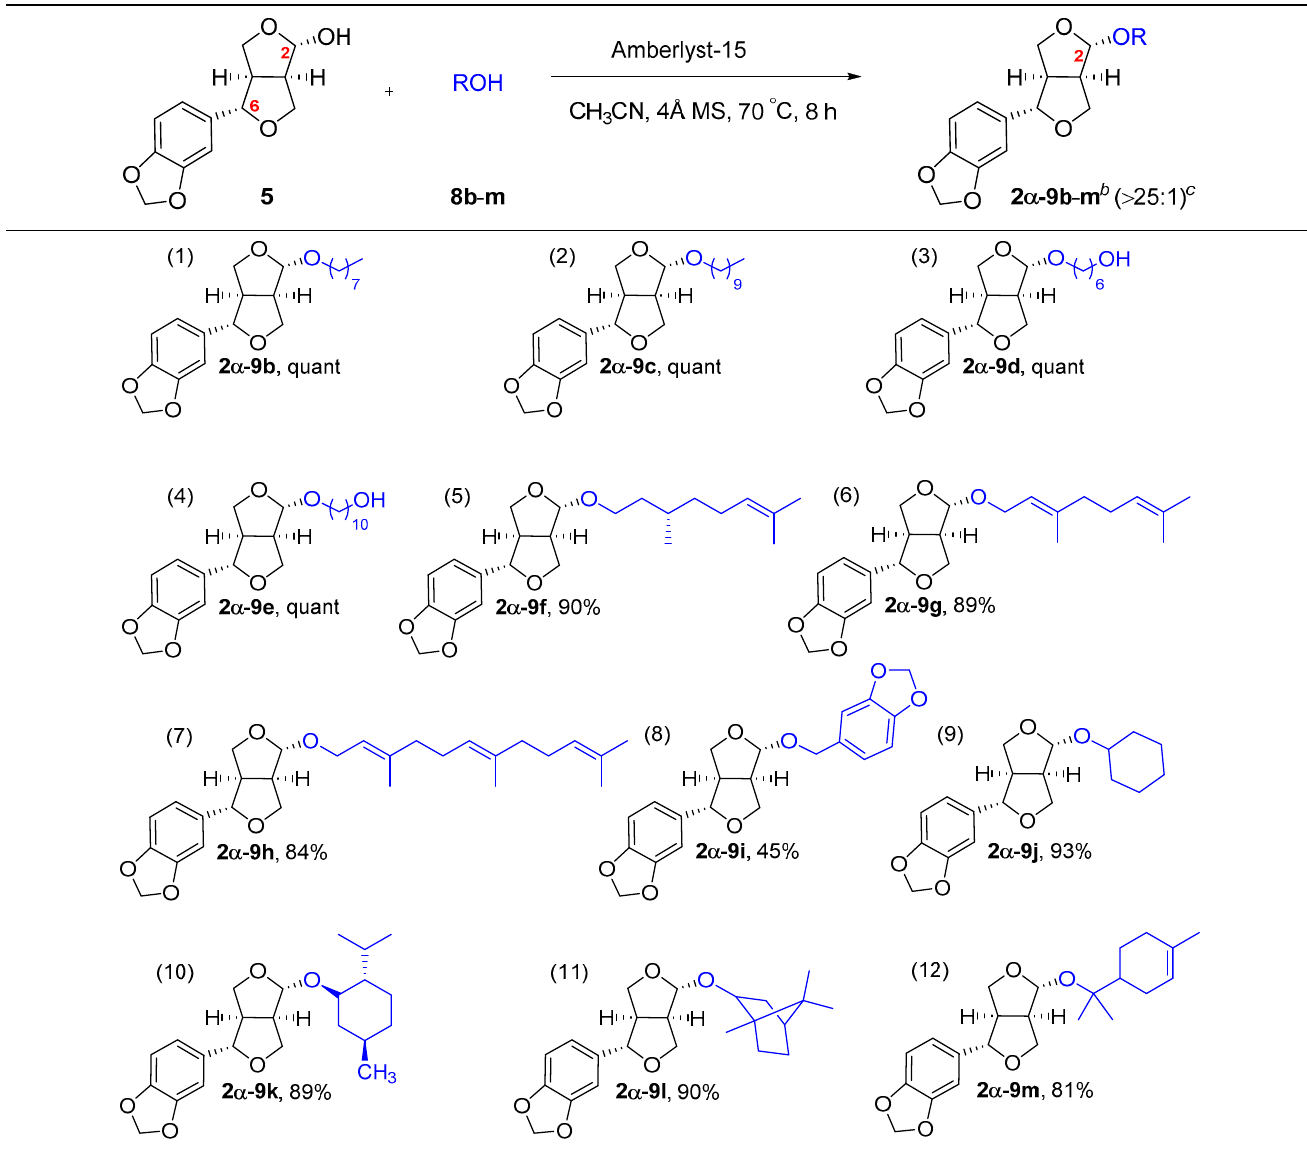
Table 2. Nucleophilic substitution of samin with Oxygen nucleophiles a .